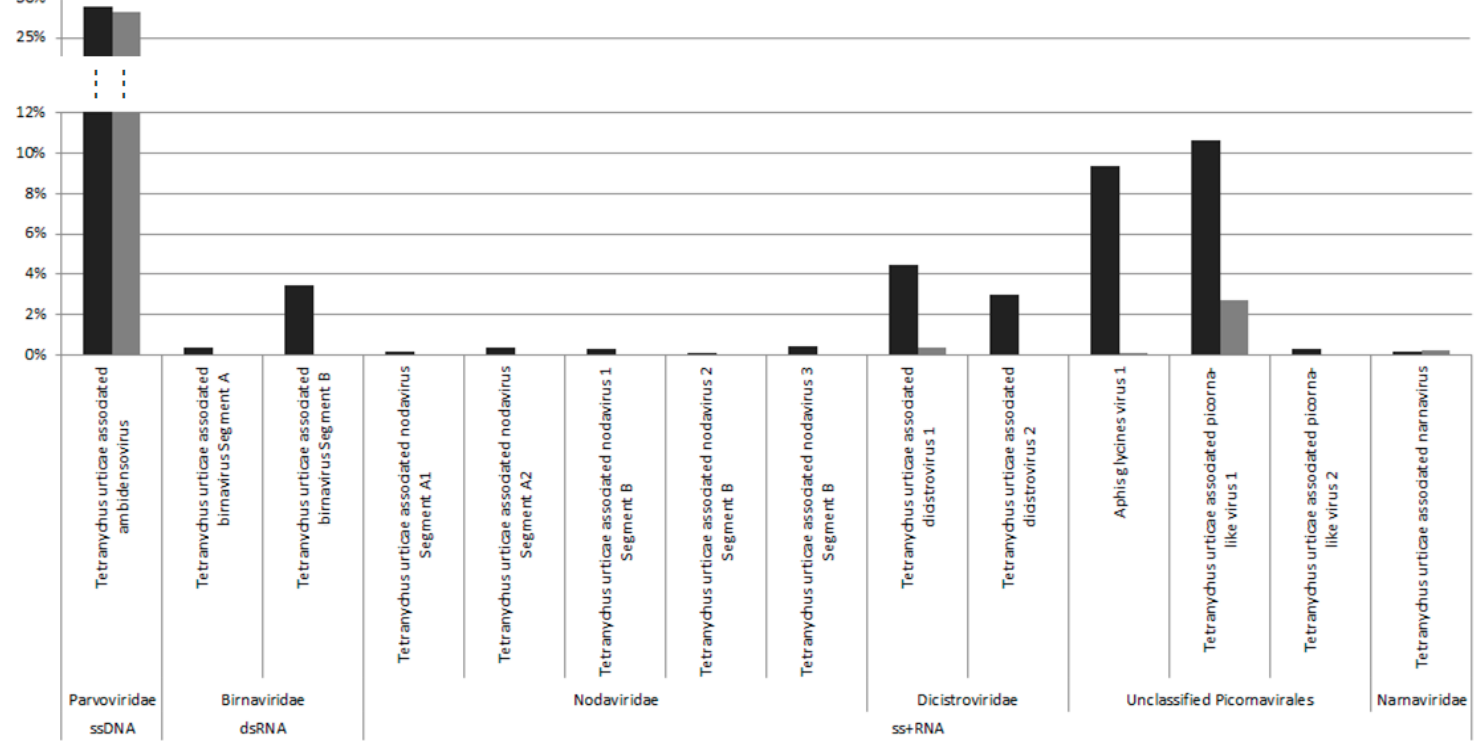
Figure 1. Relative abundance of putative viral species in the viromes of Portuguese (black) and French (grey) T. urticae colonies.